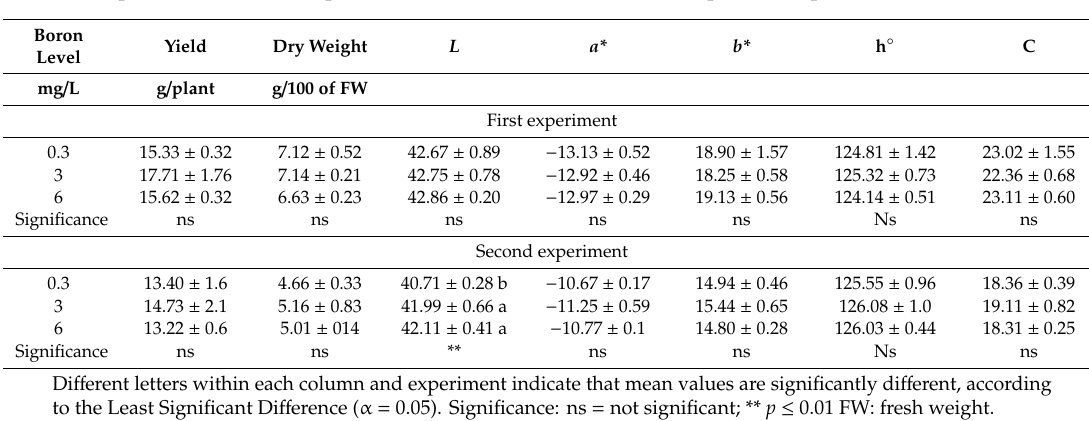
Table 1. E ff ects of di ff erent boron level in the nutrient solution on yield, dry weight, and color traits in edible parts of wild (first experiments) and commercial (second experiment) purslane.